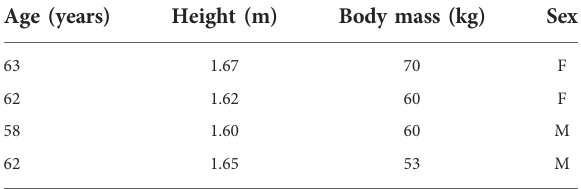
TABLE 2 Specimen donor